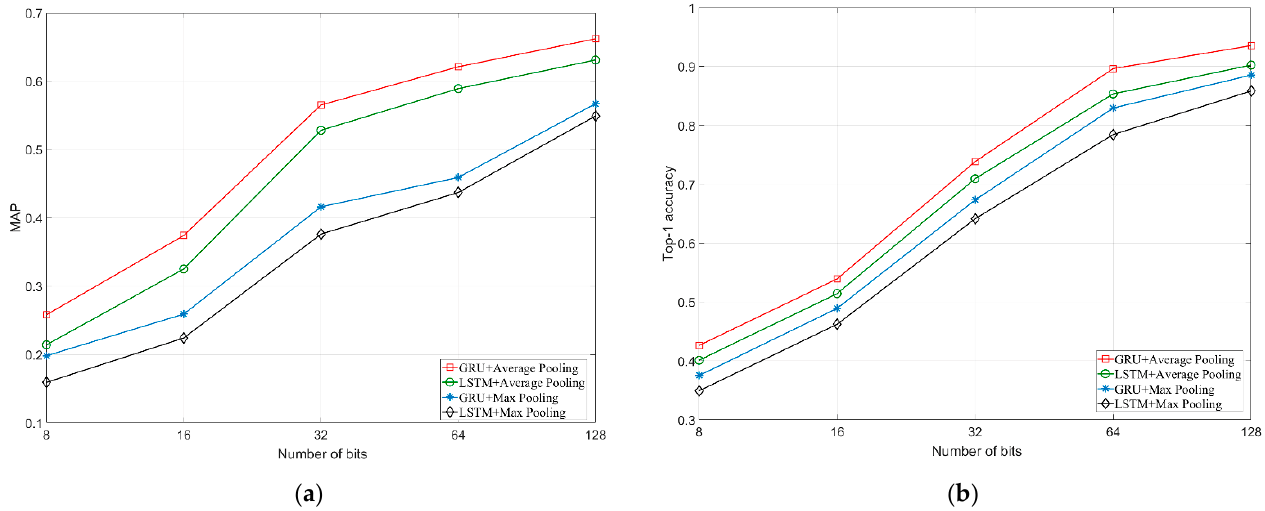
Figure 6. The accuracy comparison between GRU and LSTM with different pooling methods: ( a ) MAP comparison; ( b ) Top-1 accuracy comparison.